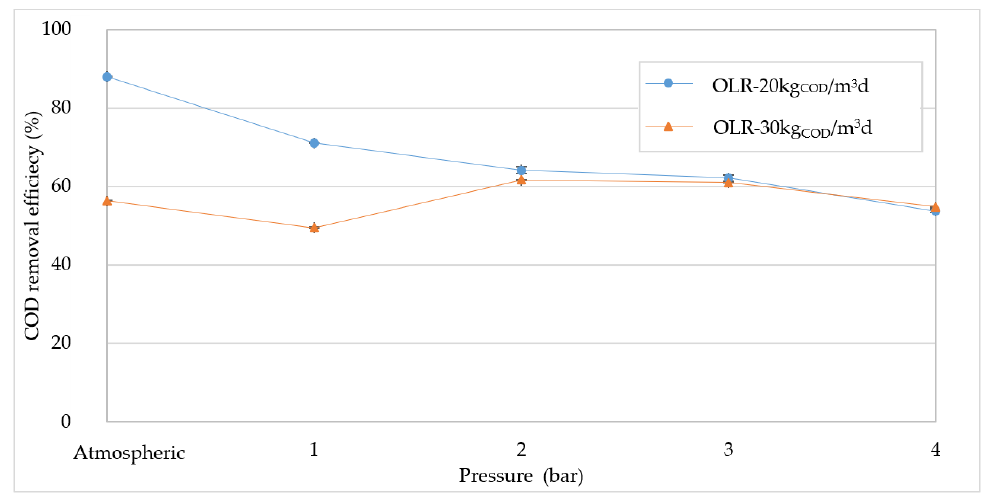
Figure 2. Chemical oxygen demand ( COD) removal efficiency at increasing pressures.